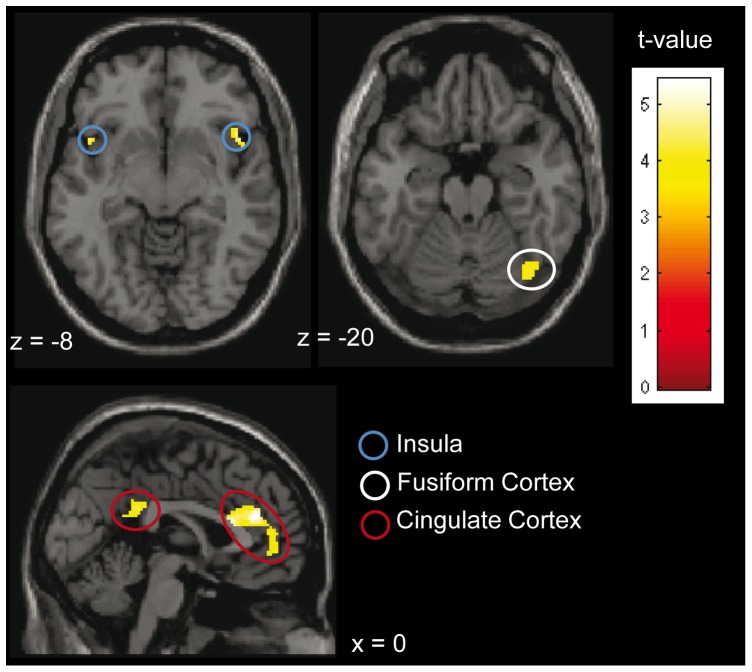
Activation in response to the body odors across all participants (n = 26).Parameters: k≥20; p<0.001; contrast: ON vs. OFF. For visualization a normalized template provided by SPM 8 software (single_subj_T1.nii) was used.